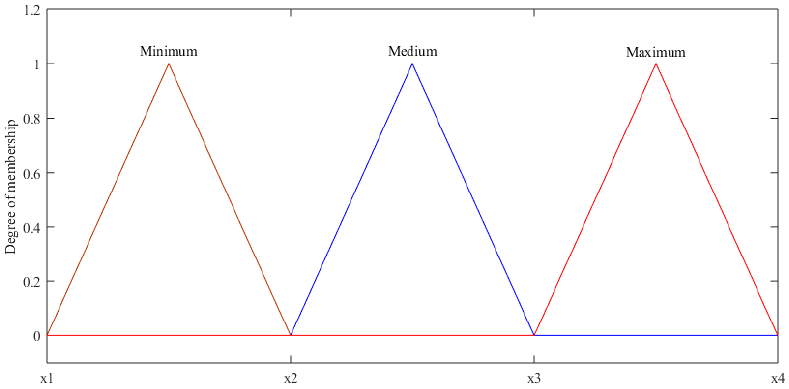
Figure 7. Actuators’ working-level graph with equivalent power ratings (watts).